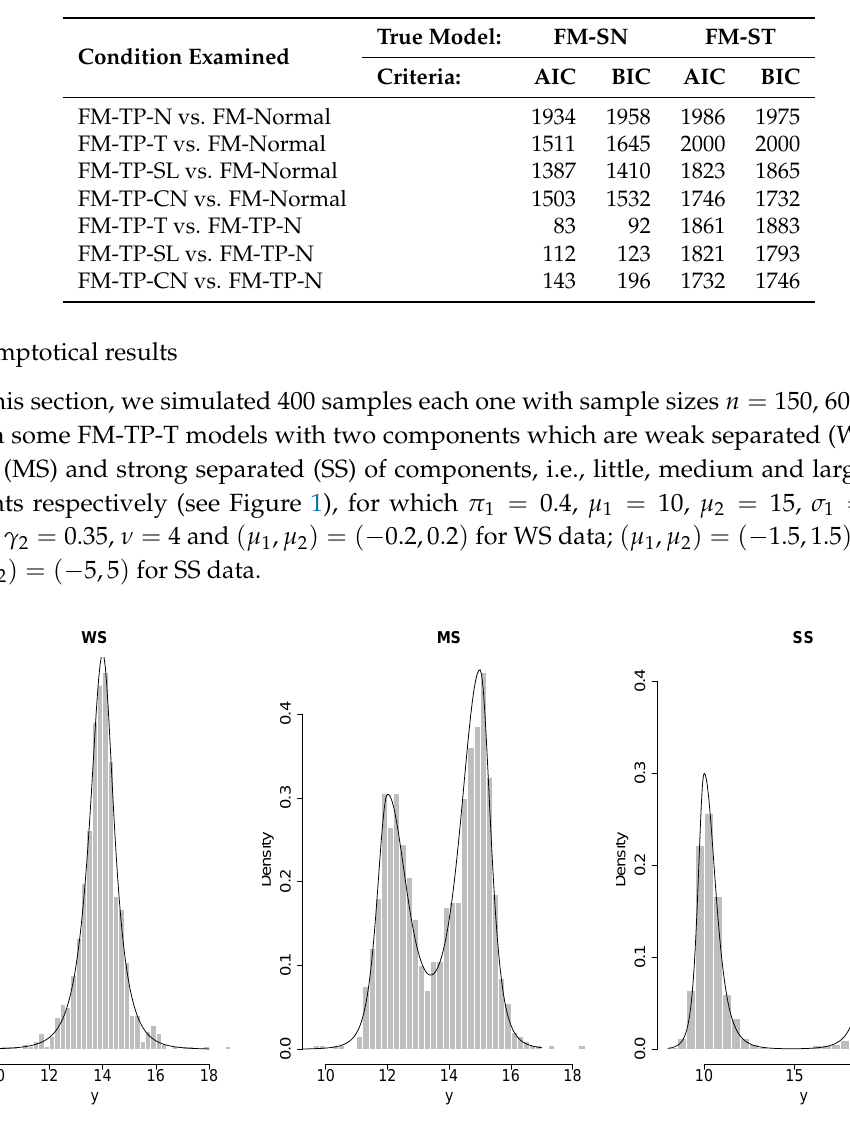
Table 2. The number of times (out of 2000) the true FM models chosen under seven proposed hypotheses.